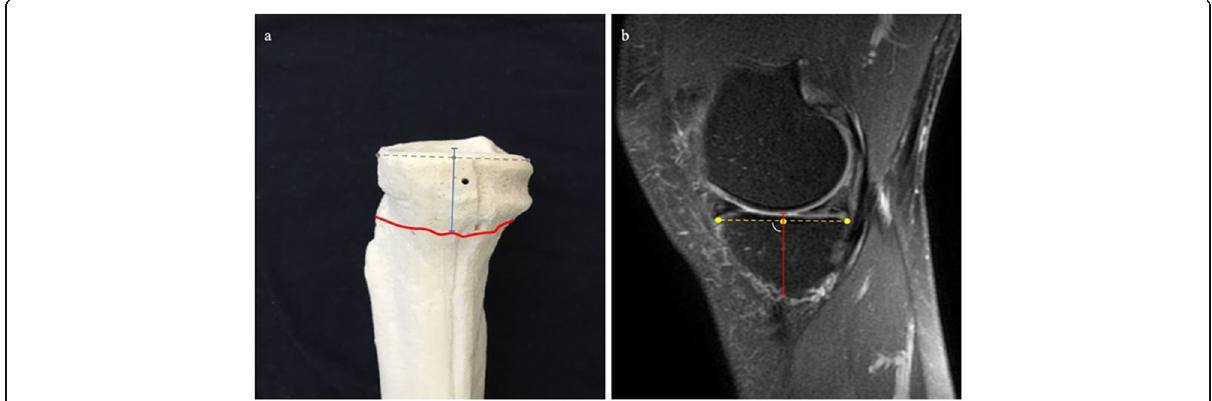
Fig. 2 a IMGA – JL Sag (blue) drawn on a 3D model. IMGA course in red and the reference line of the medial tibial plateau in grey. b . IMGA-JL Sag on T2w with fat suppression sagittal sequence